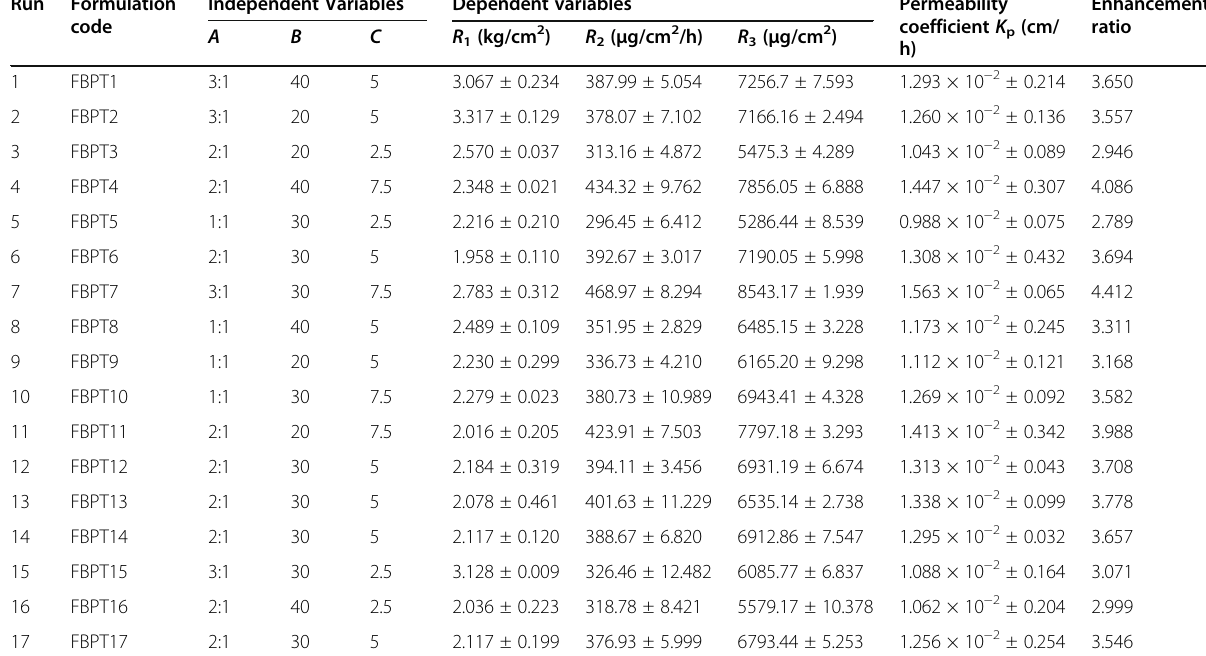
Table 2 Test design and results of response surface analysis Run Formulation